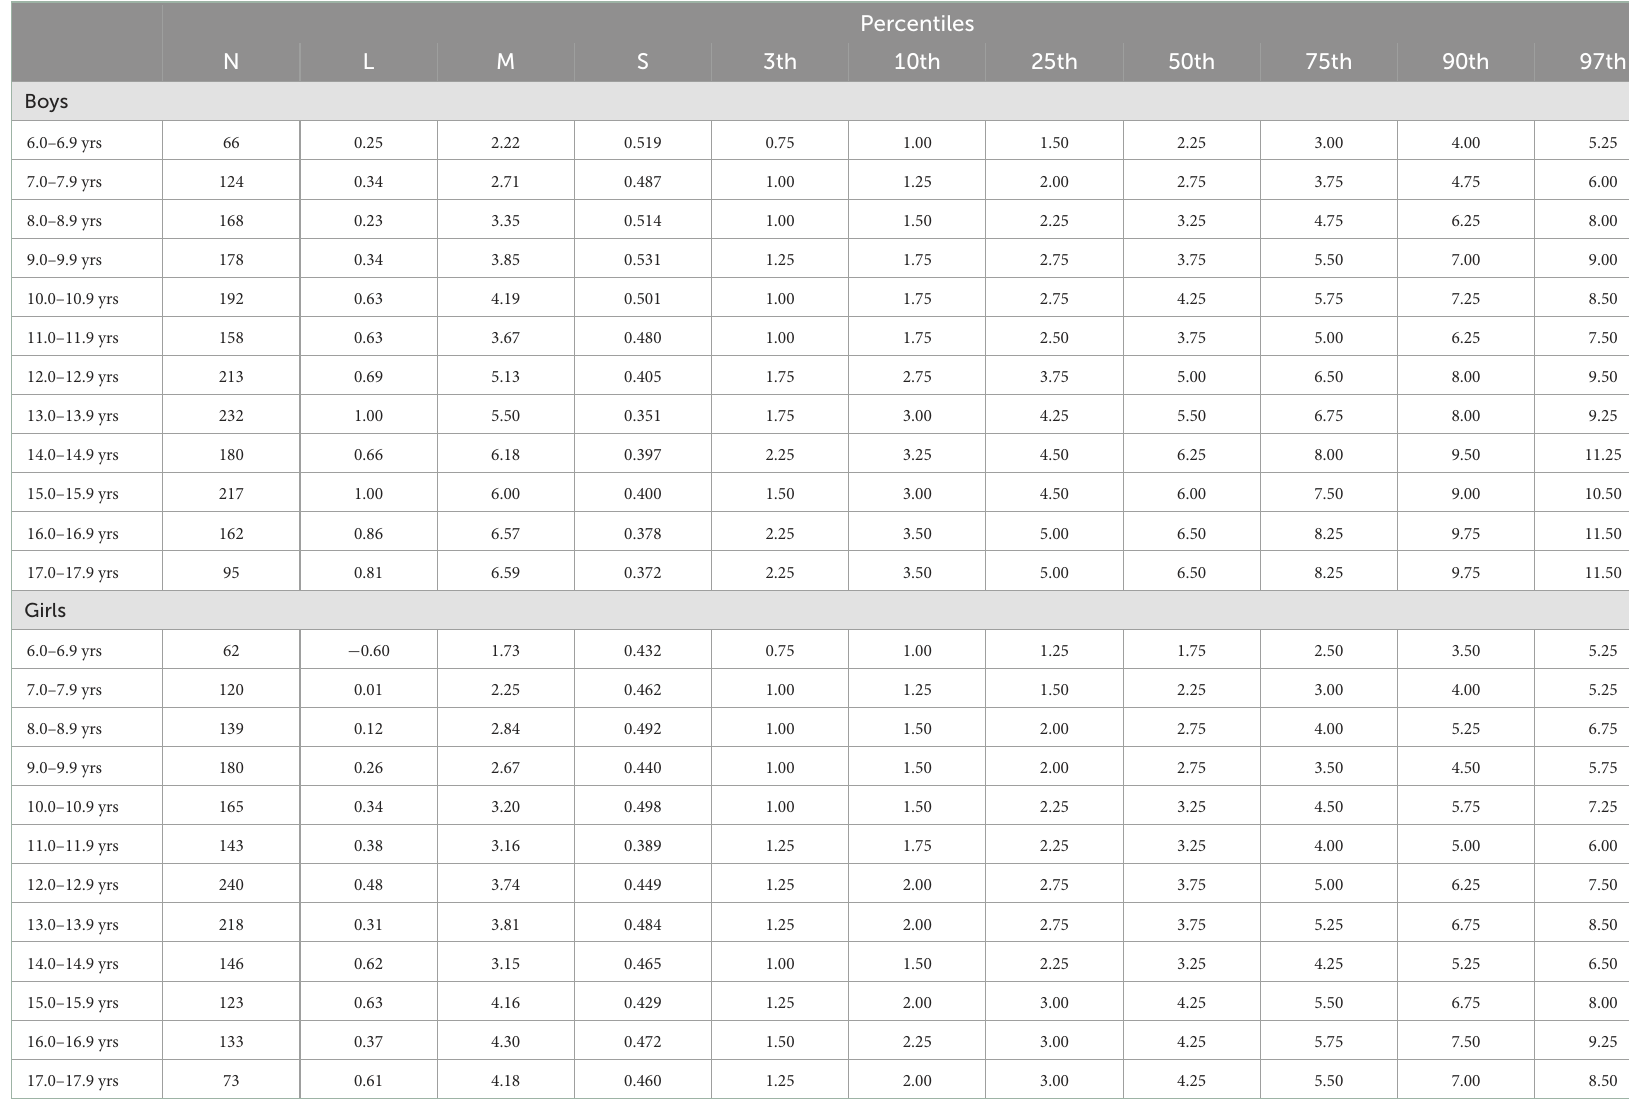
TABLE 3 Percentile reference values for the number of stages completed during the 20-m shuttle run test according to age and gender in Québec children and adolescents (N =